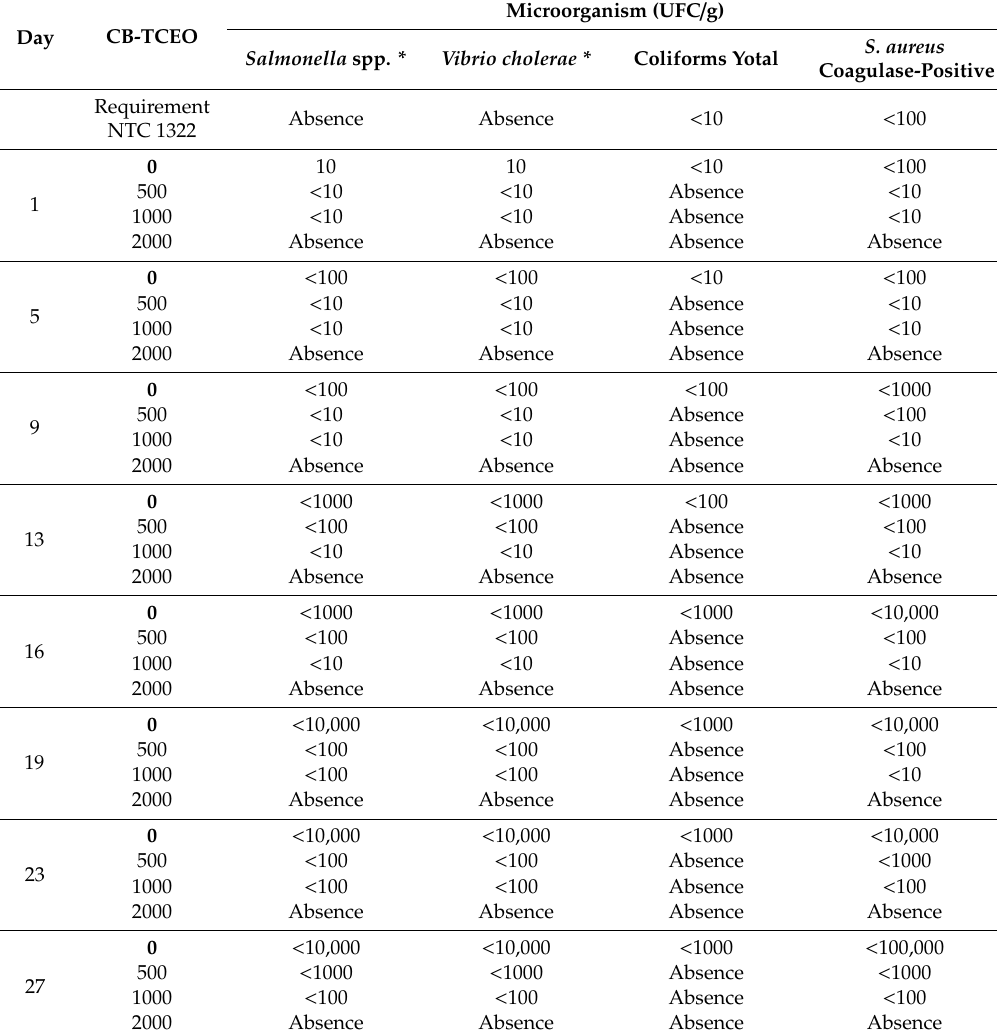
Table 3. Microbiological parameters of Oreochromis mossambicus fillets refrigerated at 4 ◦ C according to NTC